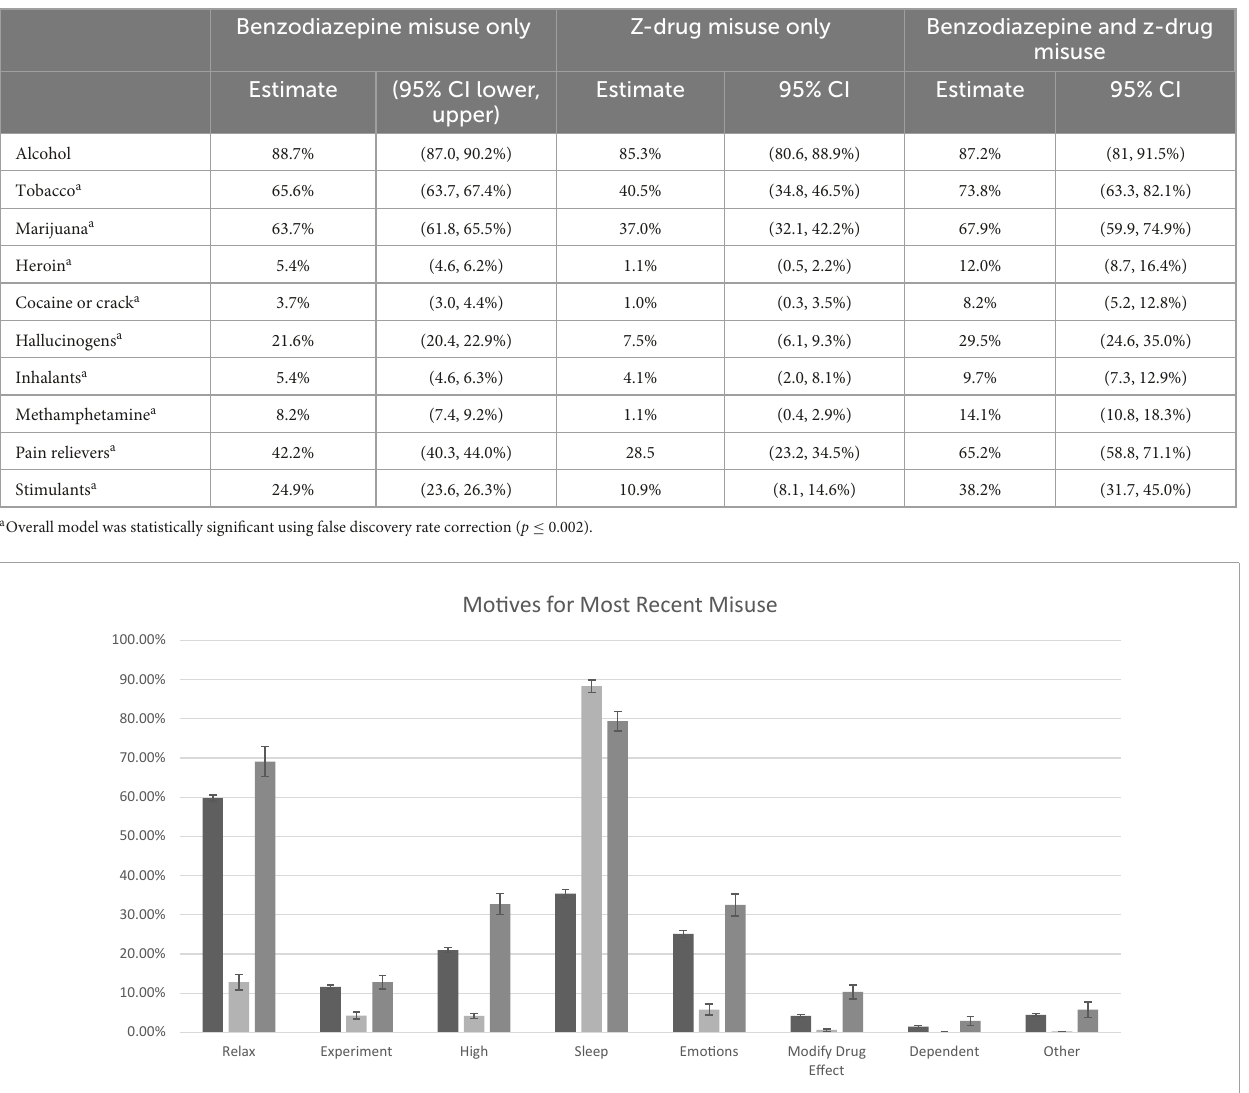
TABLE 2 Estimated population prevalence of past-year substance use among people reporting past-year benzodiazepine and z-drug